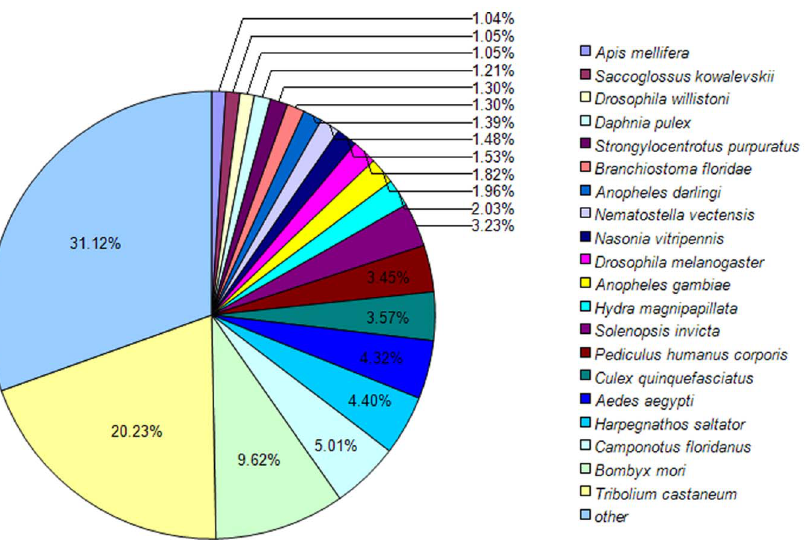
Figure 1. Species distribution of the BLASTX results. Note: This figure shows the species distribution of unigene BLASTX results against the NCBI-Nr protein database with a cutoff E value , 10 2 5 . Different colors represent different species. Species with proportions of more than 1% are shown.